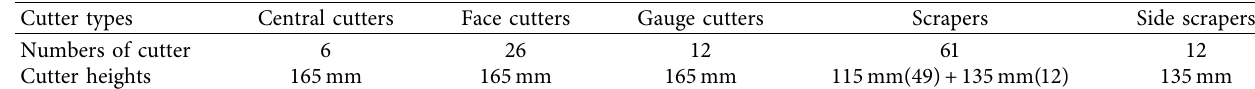
Figure 3: Shield cutterhead components. Table 1: Disc cutter specifications.